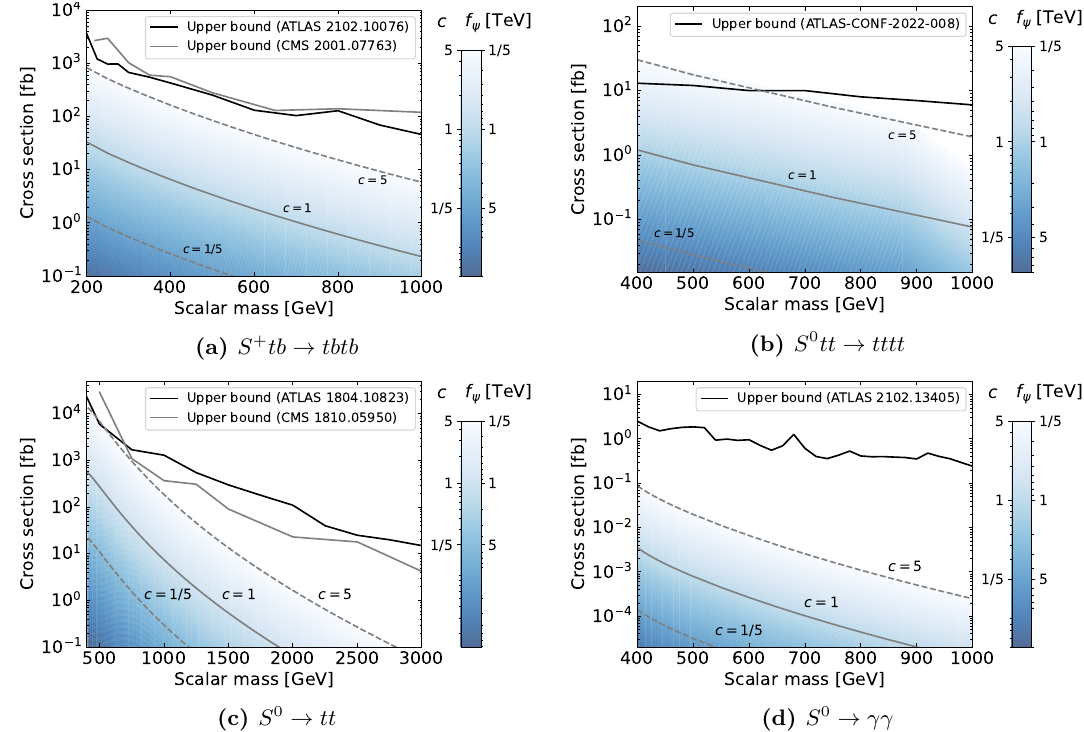
Figure 11. Bounds on the single production of pNGBs in association with two third- generation quarks. The blue shaded area indicates typical cross sections assuming that only one scalar is present. The coupling to the quarks is given by c m t and the side band maps the blue shade to f ψ the corresponding value of c (for f = 1 TeV) and f (for c = 1 ). From a model-building point ψ ψ of view, it is always possible to choose a larger scale, f 1 TeV. Hence, as c ∼ O (1) , the darker ψ > shaded regions correspond to theoretically more favourable parameter points than the light and white regions.